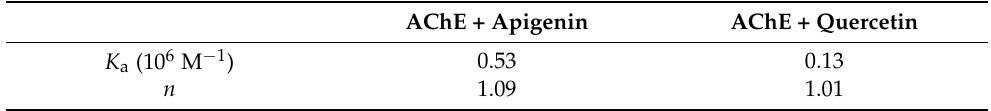
Table 5. Binding affinities ( K a ) and numbers of binding sites ( n ) for the interaction of apigenin and quercetin with